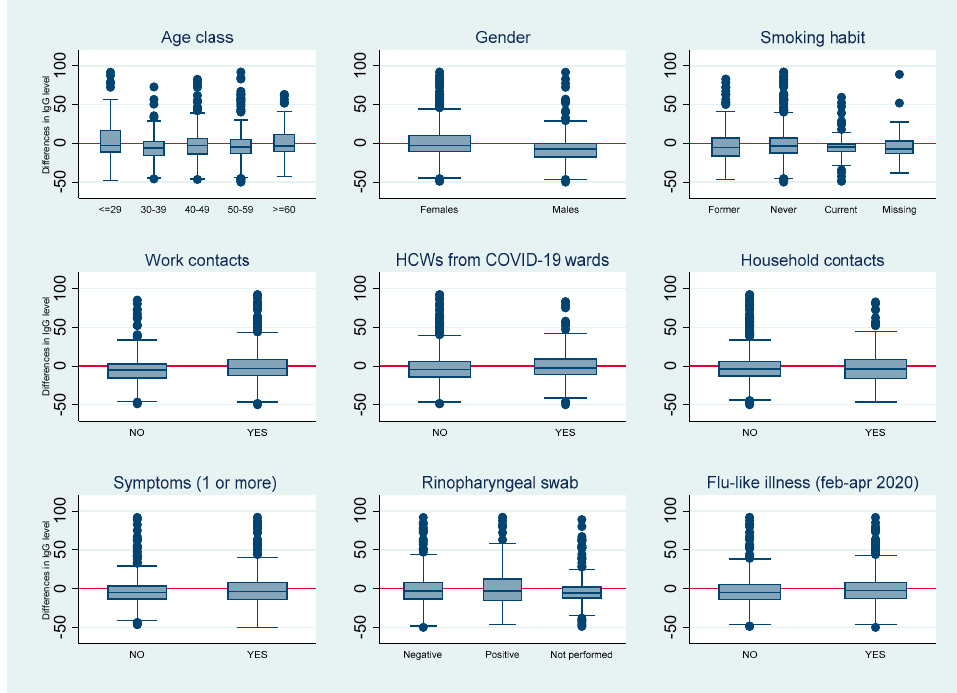
Figure 2. Absolute differences in IgG levels between 1st and 2nd phase among subjects who tested positive at the first phase, by some demographic, clinical, and occupational characteristics, CSS and UNITO workers.